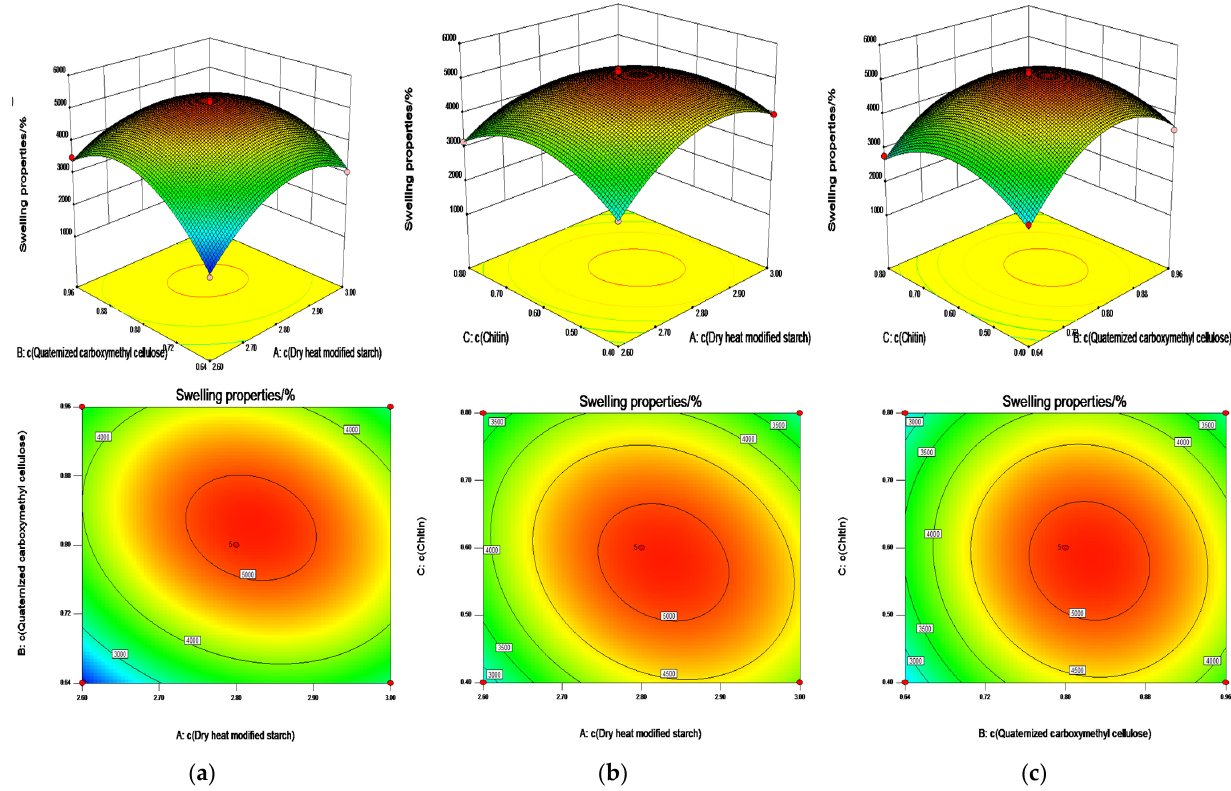
Figure 4. Contour and 3D response plots showing ( a ) the effects of concentration of dry heat-modified starch (A), concentration of quaternized carboxymethyl cellulose (B), and their interaction on the swelling properties; ( b ) concentration of dry heat-modified starch (A), concentration of chitin (C), and their interaction on the swelling properties; ( c ) concentration of quaternized carboxymethyl cellulose (B), concentration of chitin (C), and their interaction on the swelling properties.